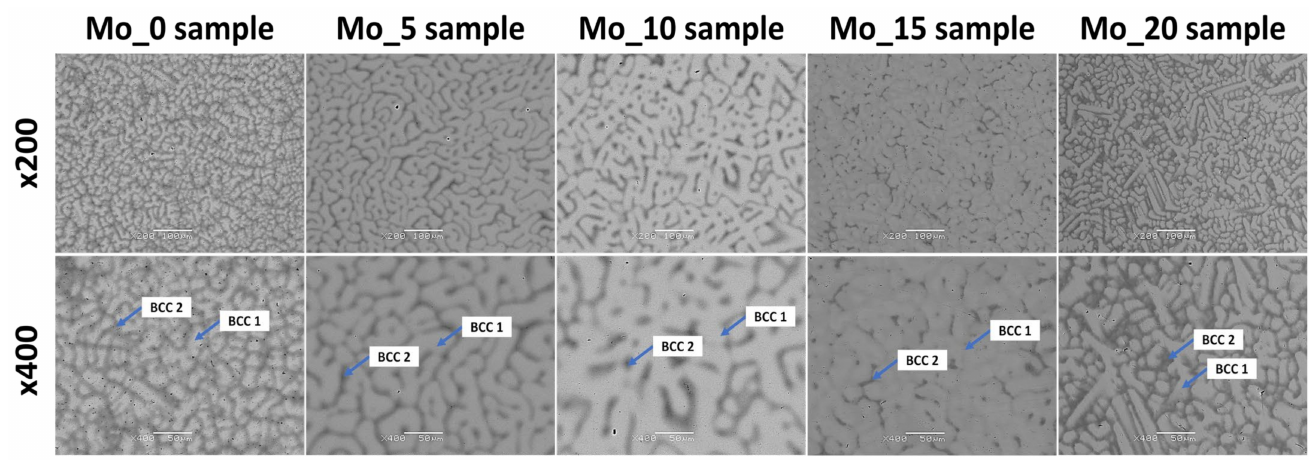
Figure 4. Backscattered electron contrast imaging mode (BSE) microstructure images of studied high entropy alloy compositions with assigned BCC solid solutions corresponding to dendritic and interdendritic